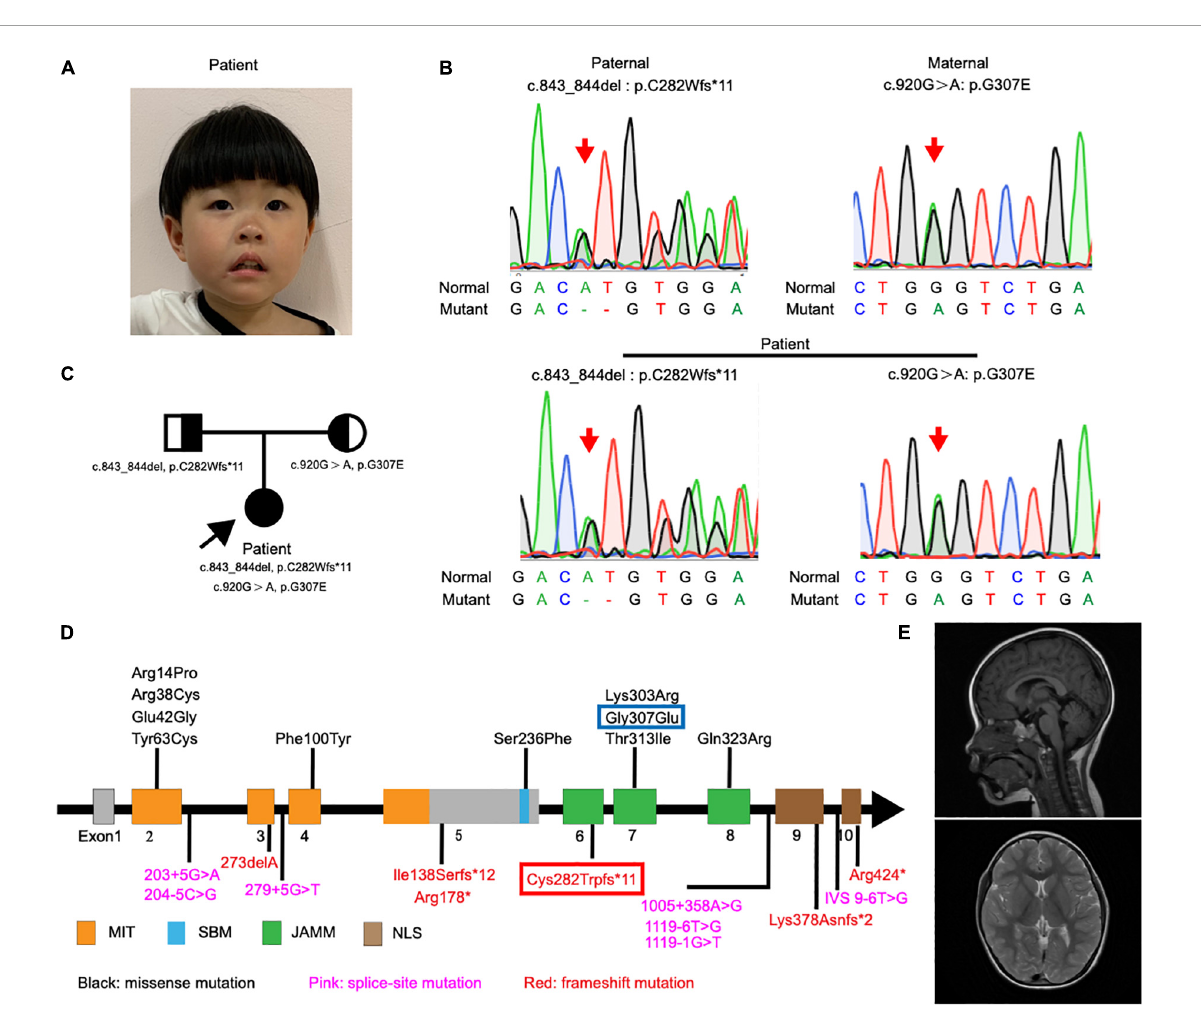
FIGURE1 Detection and location of STAMBP mutation in case patient. (A) Clinical photograph showing craniofacial phenotypes (hypertelorism, wide nasal bridge, anteverted nares, and drooping corners of the mouth). (B) Sanger sequencing of the STAMBP mutations showed that the case patient has compound heterozygous mutations from her father (c.843_844del, p. C282Wfs*11) and mother (c.920G > A, p.G307E) (arrow). (C) Pedigree of the patient. (D) Diagram indicates the location of the patients’ mutations of STAMBP described in previous reports and ours. Blue frame labels this case’s mutation inherited from her mother. Red frame labels this case’s mutation inherited from her father. STAMBP contains a microtubule-interacting and transport (MIT) domain, an SH3 binding motif (SBM), a JAMM (JAB/MPN/MOV34) motif, and a nuclear localization signal (NLS). (E) Representative images showing cerebral MRI scans of the